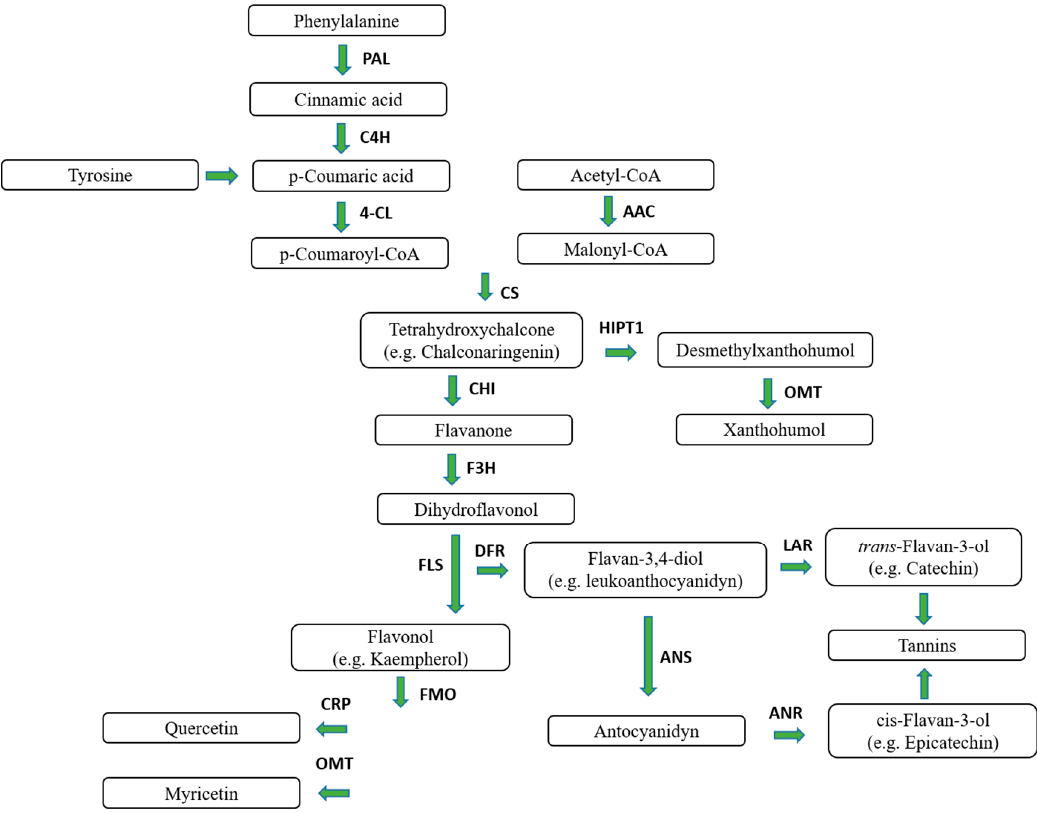
Figure 1. Biosynthesis pathways of several hop flavonoids. PAL: Phenylalanine ammonia-lyase; C4H cinnamate 4-hydroxylase, 4CL 4-coumarate-CoA ligase, AAC acetyl-CoA carboxylase, CS chalcone synthase, HIPT1 Humulus lupulus prenyltansferase-1,CHI chalcone isomerase, OMT O -methyltransferase, F3H flavanone 3-hydroxylase, FLS flavonol synthase, DFR dihydroflavonol 4-reductase, LAR leucoanthocyanidin reductase, ANS anthocyanidin synthase, ANR anthocyanidin reductase, FMO flavonoid 3-monooxygenase, CPR cytochrome P450 reductase, F3 ′ 5 ′ H flavonoid 3 ′ 5 ′ -hydroxylase.